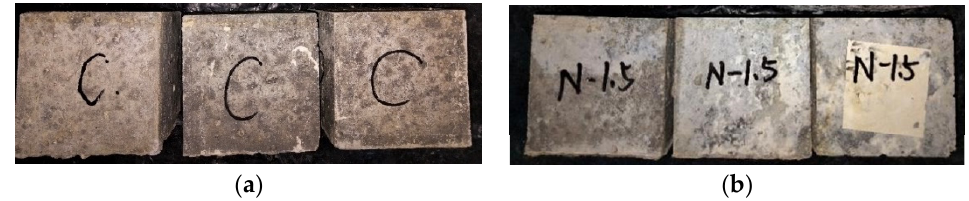
Figure 14. The appearance changes of the GPC specimen after the wet–dry cycle. ( a ) Samples of group C; ( b ) Samples of group N ‐ 1.5.